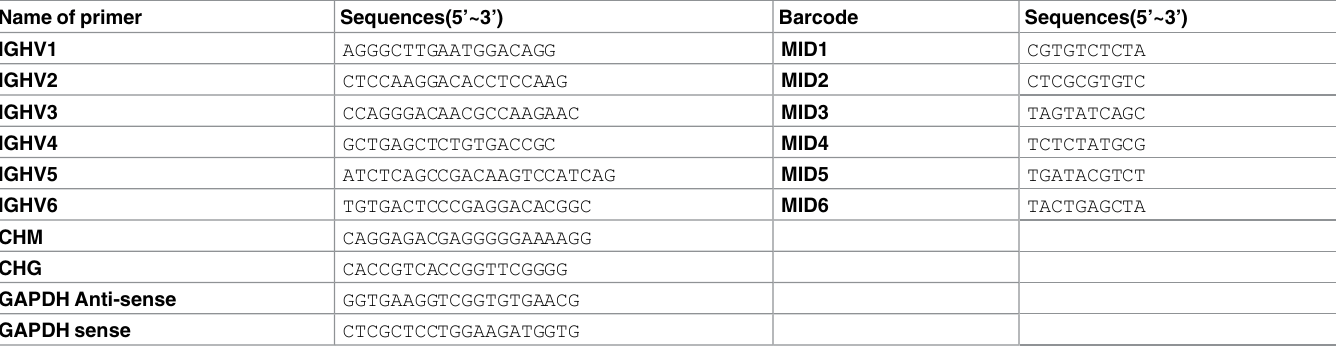
Table 1. Human IGHV/CHM/CHG primer sequences and barcode